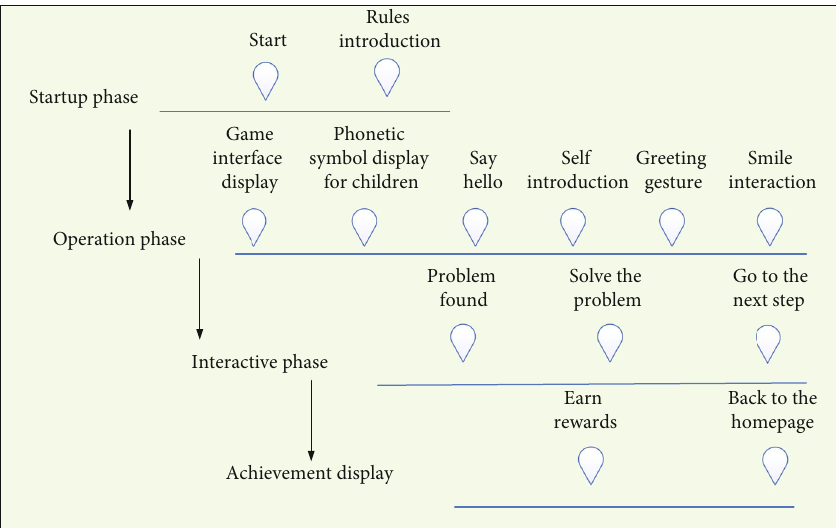
Figure 2: “ Get To Know Your Phonetic Symbols Friends “ game tutorial.